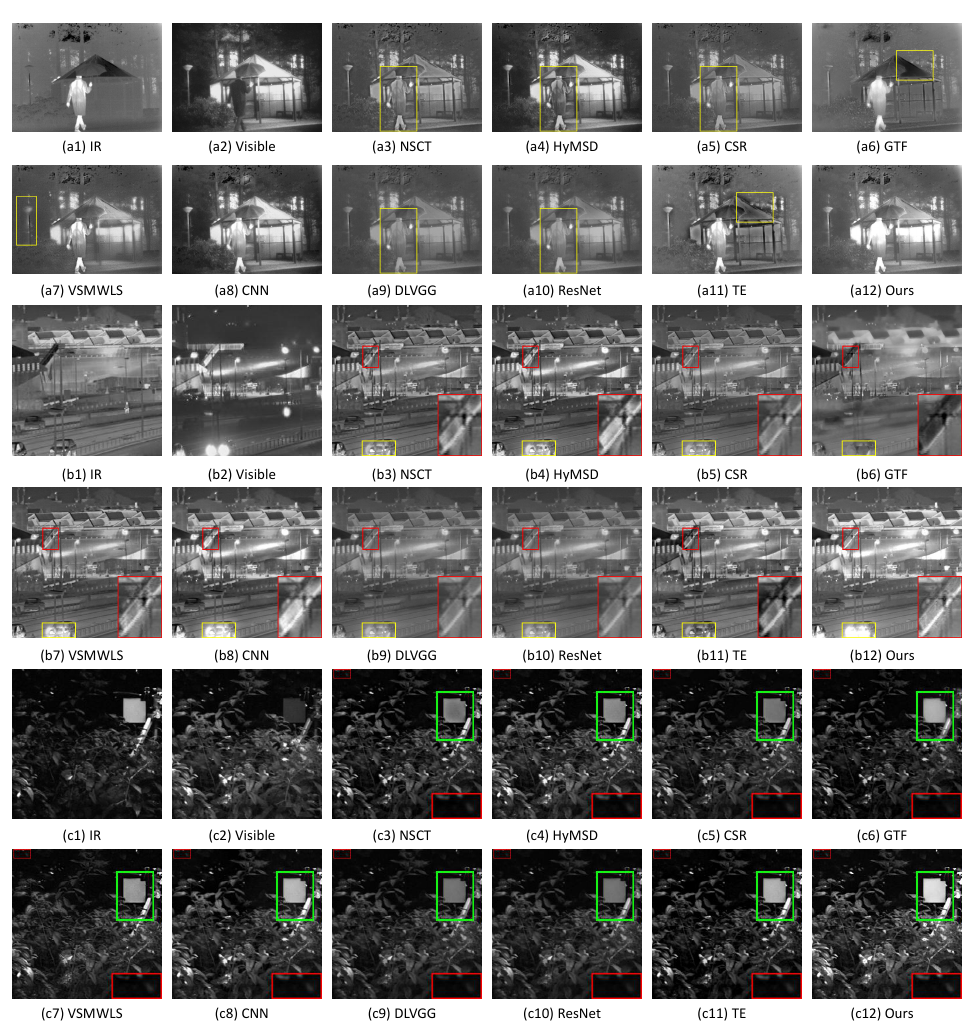
Figure 9. Fusion performance of various methods on the image pairs. From top to bottom: ‘Kaptein1654’, ‘Factory’, and ‘S1’. Table 2. Average values of each metric for 21 source image pairs of various fusion methods. The metric value marked in bold indicates the best performance, and the metric value marked with an underline denotes the second best